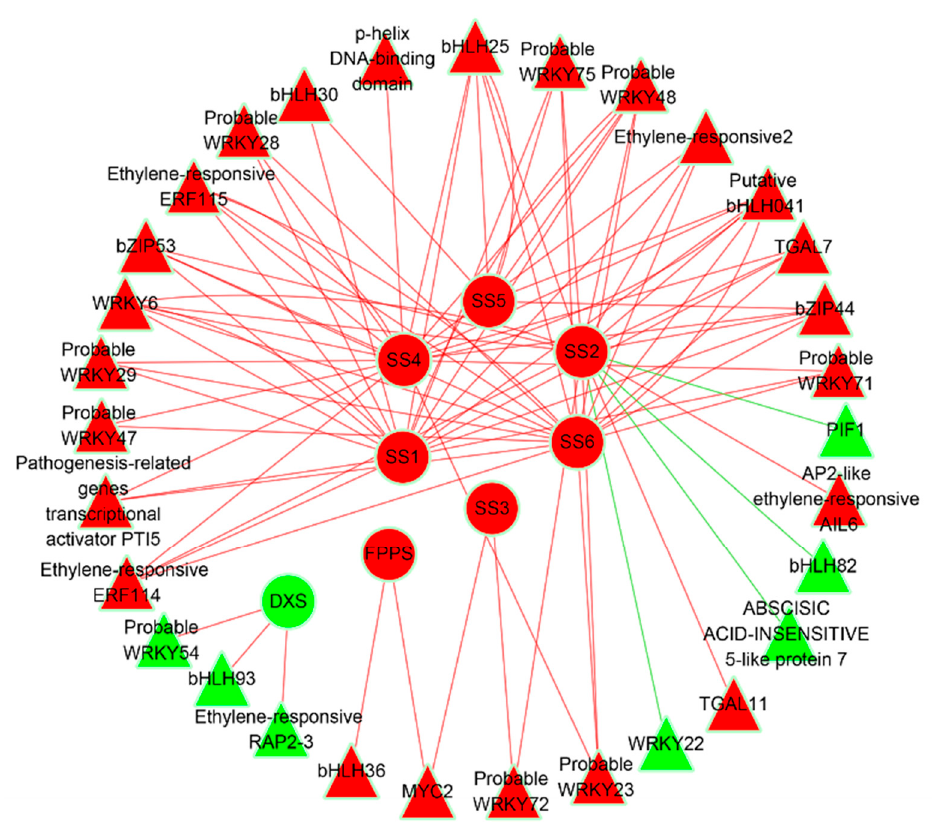
Figure 5. The co − expression network of DEGs involved in sesquiterpene biosynthesis and transcription factors. Red nodes represent up − regulated genes and green nodes represent down − regulated genes. The genes involved in sesquiterpene biosynthesis are represented by circles and transcription factors are represented by triangles. Red lines represent positive correlation and green lines represent negative correlation between genes and transcription factors.